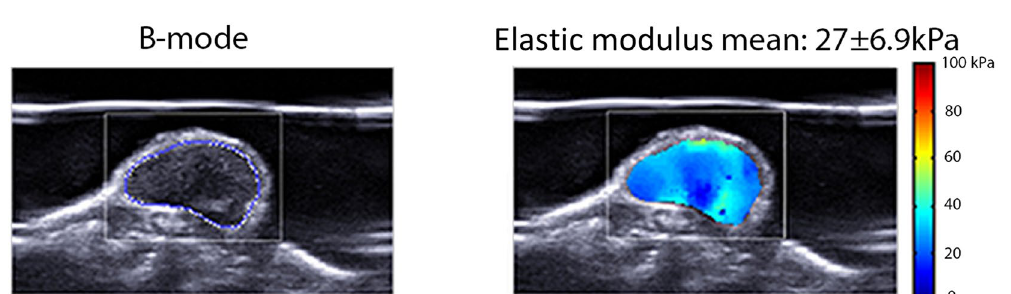
Figure 3. Elastic (Young’s) modulus calculation. Specially written software allows the ROI to be drawn on the B-mode (left), which is reciprocated on the elasticity image (right). The stiffness calculation was performed off- line once scan data had been